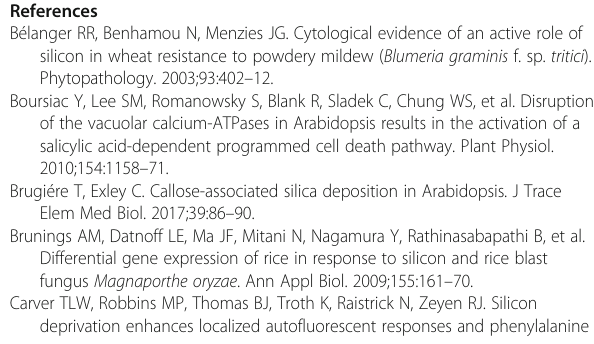
Figure S2. Silicon content in deionized water and tap water, different soil media, and in leaves of Col-0 plants grown in regular soil matrix or perlite. Figure S3. Silicon content in leaves of different Arabidopsis